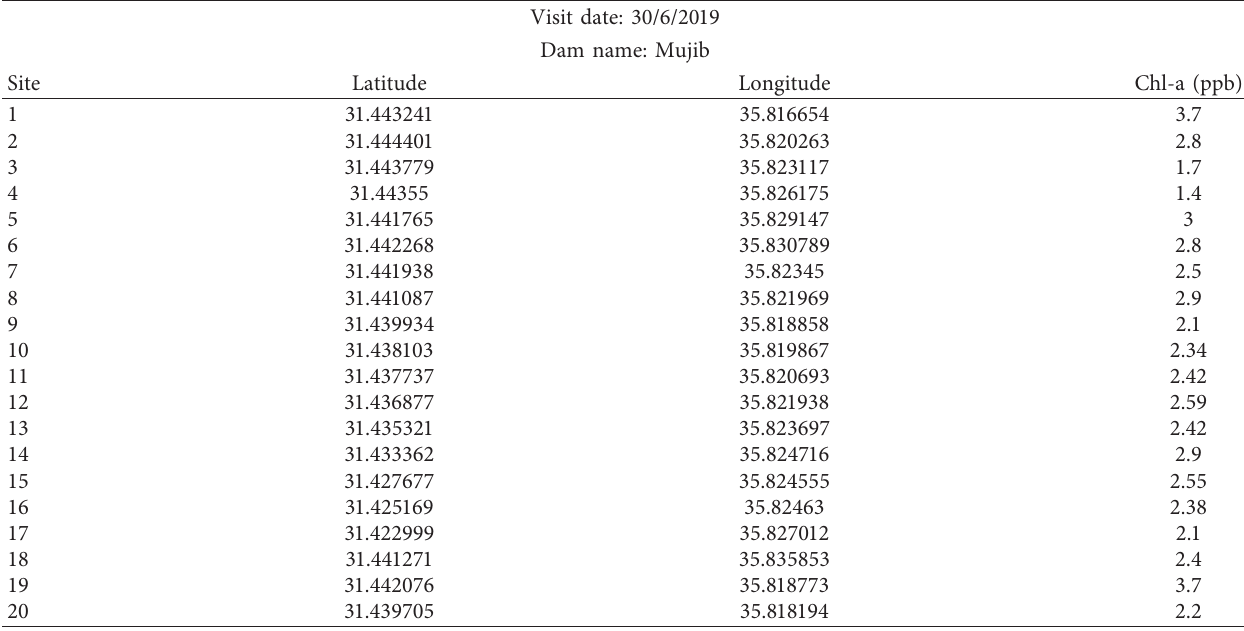
Table 2: Chl-a concentration and corresponding sampling points’ coordinates of samples collected from Mujib Dam.